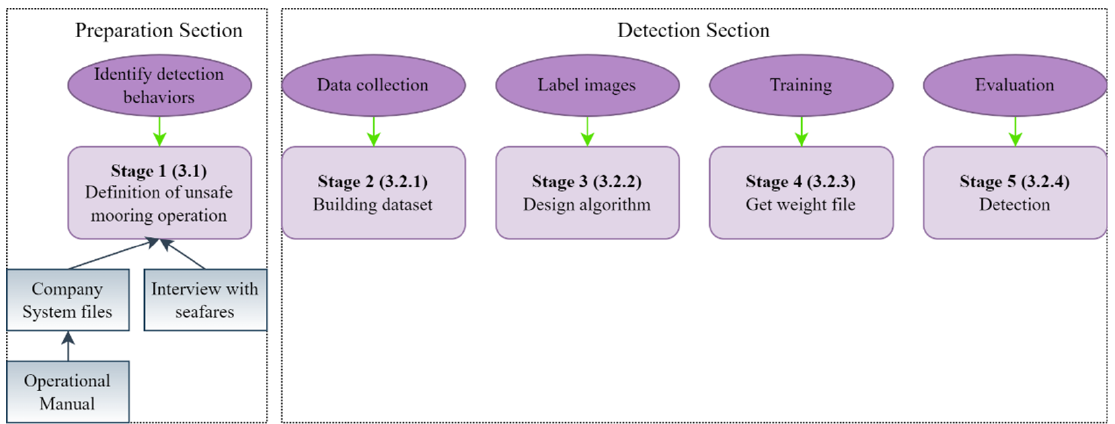
Figure 1. Research